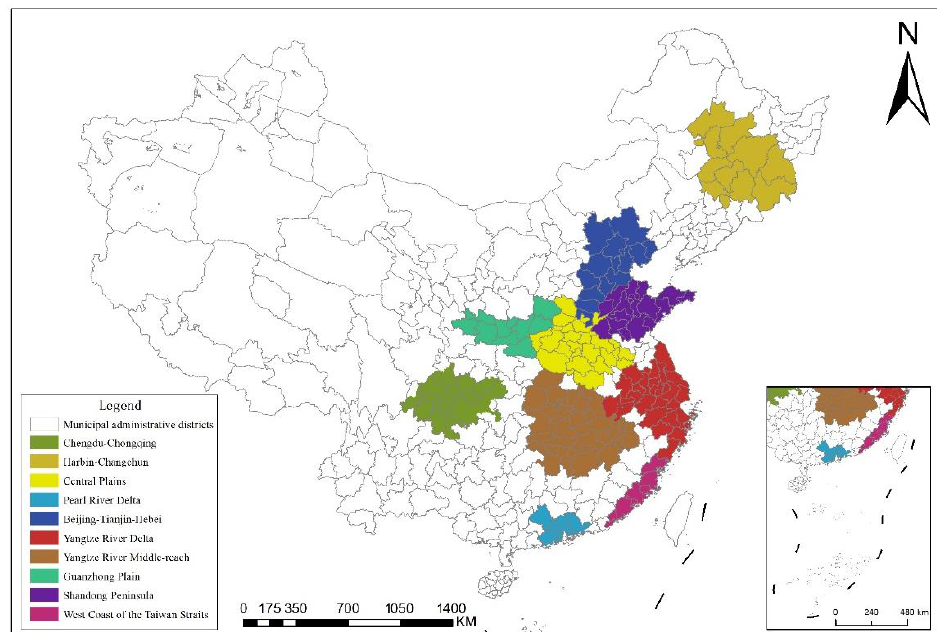
Figure 2. Location map of study area.